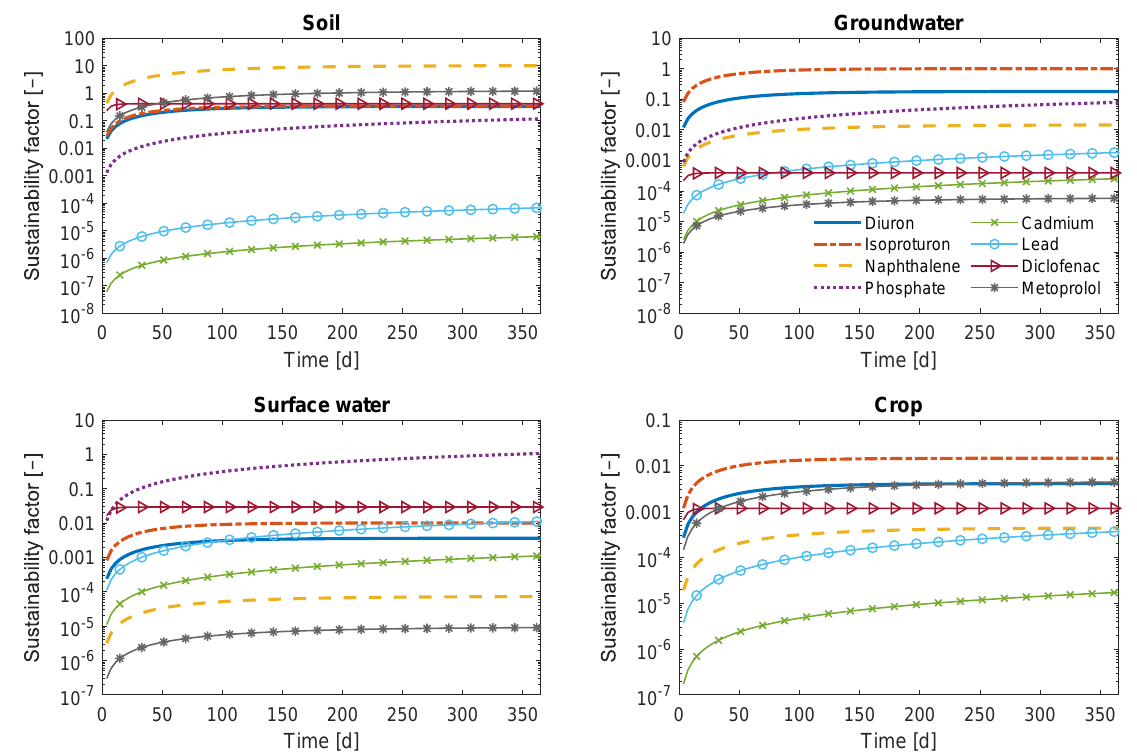
Figure 2. The short-term change of the sustainability factors over time, plotted for each contaminant and environmental compartment. Note the logarithmic scale of the